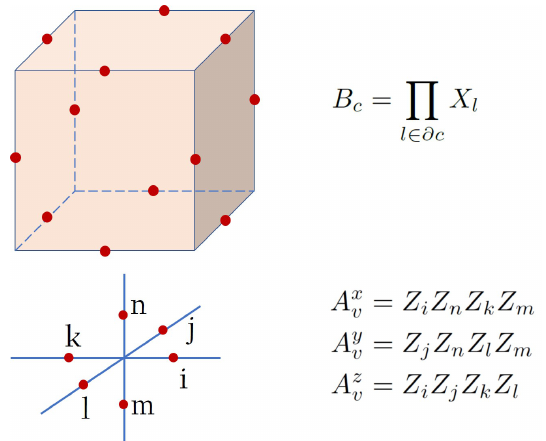
Figure 3: The X-Cube model [ 8 ] is defined on a cubic lattice with a qubit on each link. The Hamiltonian is a sum of commuting terms, with B vertex stabilizers